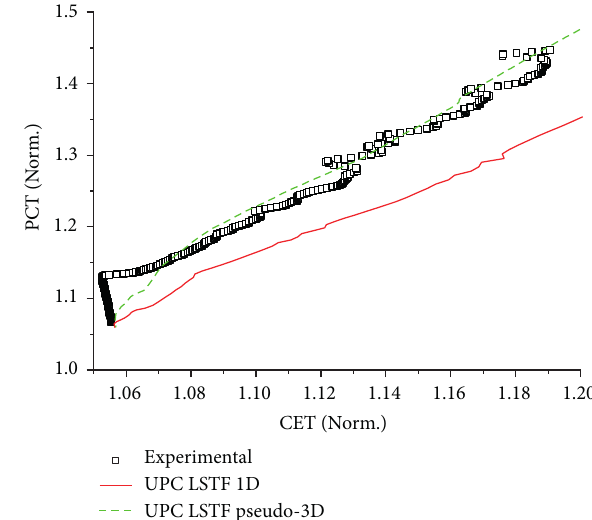
Figure 15: Core level.